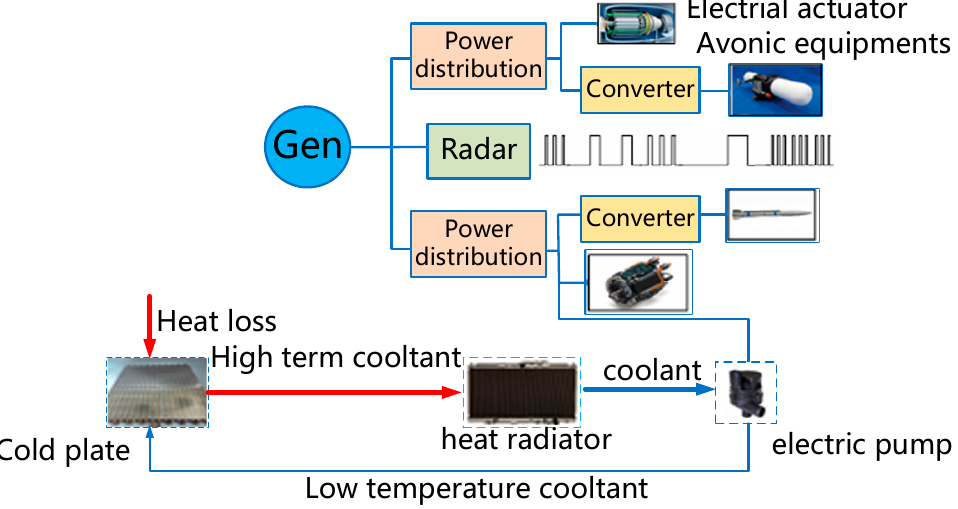
Figure 16. The aircraft electrical power system architecture for large power pulse load with cooling function (single channel).